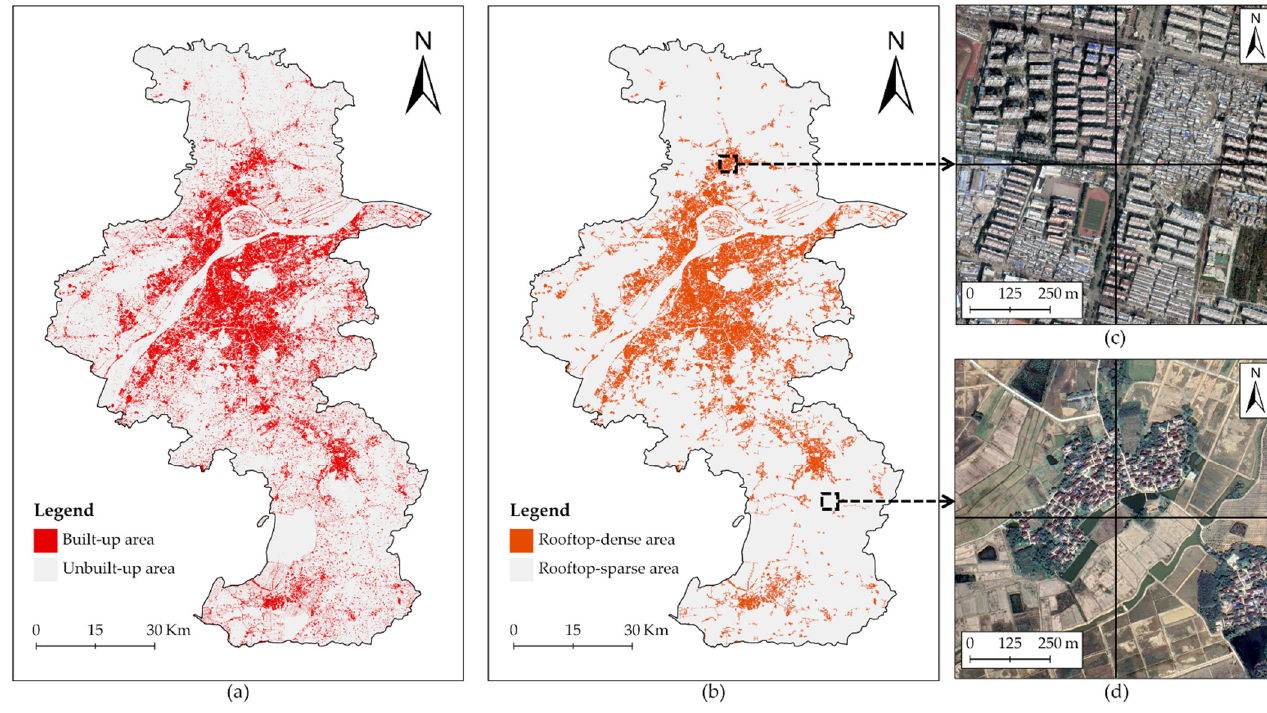
Figure 4. Sampling area stratification based on the patch size of the built-up area; ( a ) division of the built-up and unbuilt-up areas in Nanjing; ( b ) division of the rooftop-dense and rooftop-sparse areas in Nanjing; ( c ) the four adjacent sample cells in rooftop-dense stratum; ( d ) the four adjacent sample cells in rooftop-sparse stratum.